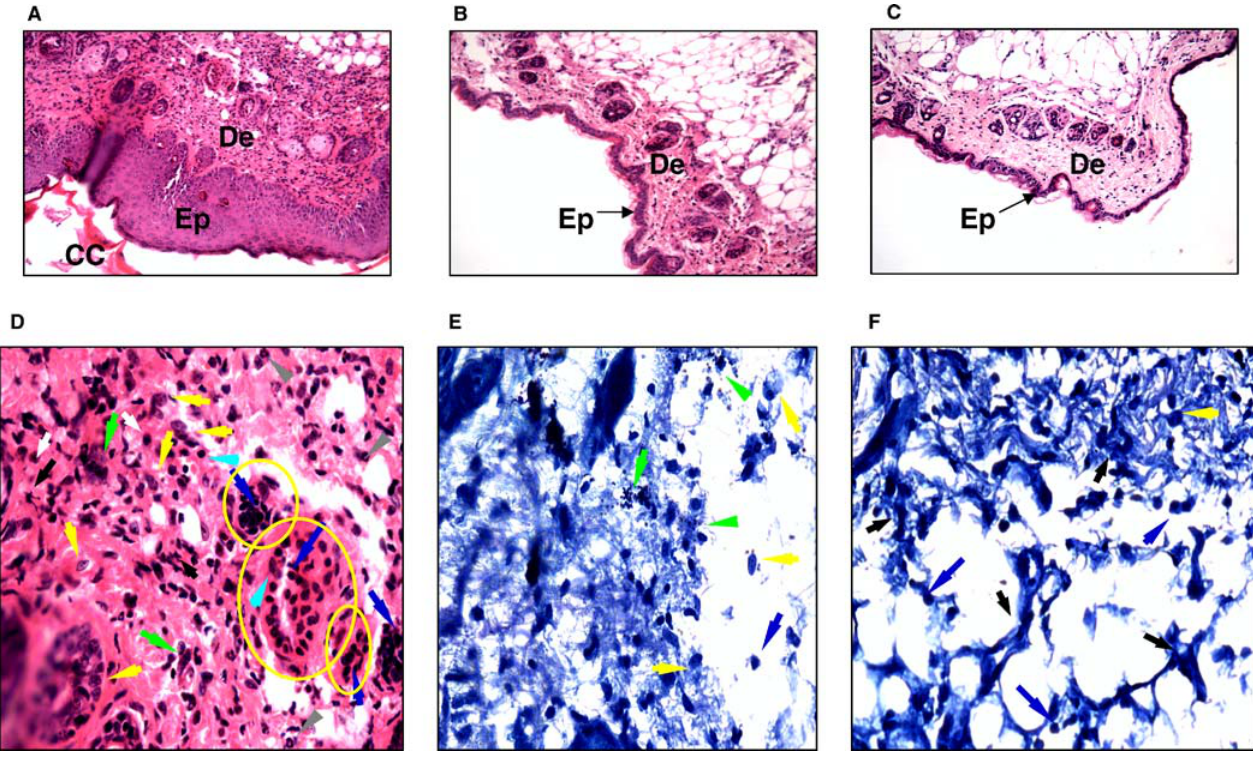
Figure 2. Skin Histological Response in Immunized Mice Infested with Virus-Infected and -Uninfected Ticks Histological profiles of skin sections taken at d 4 of TBEV-infected I. ricinus tick challenge on Balb/c mice immunized with either TRP2 (A, D), TRP5 (E), or GST (C, F), or unimmunized (B). Stained with hematoxylin and eosin (A–D) or ‘‘ Hema Gurr ’’ Rapid stain BDH (E, F) [19]. (A) (magnification 20 3 ) TRP2- immunized animals, (B) (magnification 20 3 ) control unimmunized, and (C) (magnification 20 3 ) GST-immunized animals. Ep, epidermis; De, dermis; CC, cement cone of I. ricinus . (D–E) (magnification 63 3 ) denote skin sections from TRP2 and TRP5 immunized mice, respectively, showing: perivascular cuffing ¼ yellow circle; degranulating mast cells ¼ green arrow; numerous lymphocytes ¼ blue arrow; frequent macrophages ¼ yellow arrow; and some eosinophils ¼ white arrow; dermal dendrocytes ¼ black arrow; neutrophils ¼ gray arrow; and basophils ¼ light blue arrow. (F) (magnification 63 3 ) skin sections from GST control immunized mice showing lymphocytes, macrophages, and dermal dendrocytes. DOI: 10.1371/journal.ppat.0020027.g002